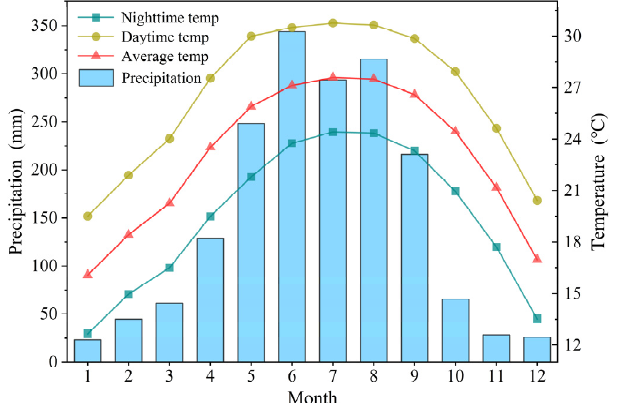
Figure 9. Intra-annual changes of temperature and precipitation.